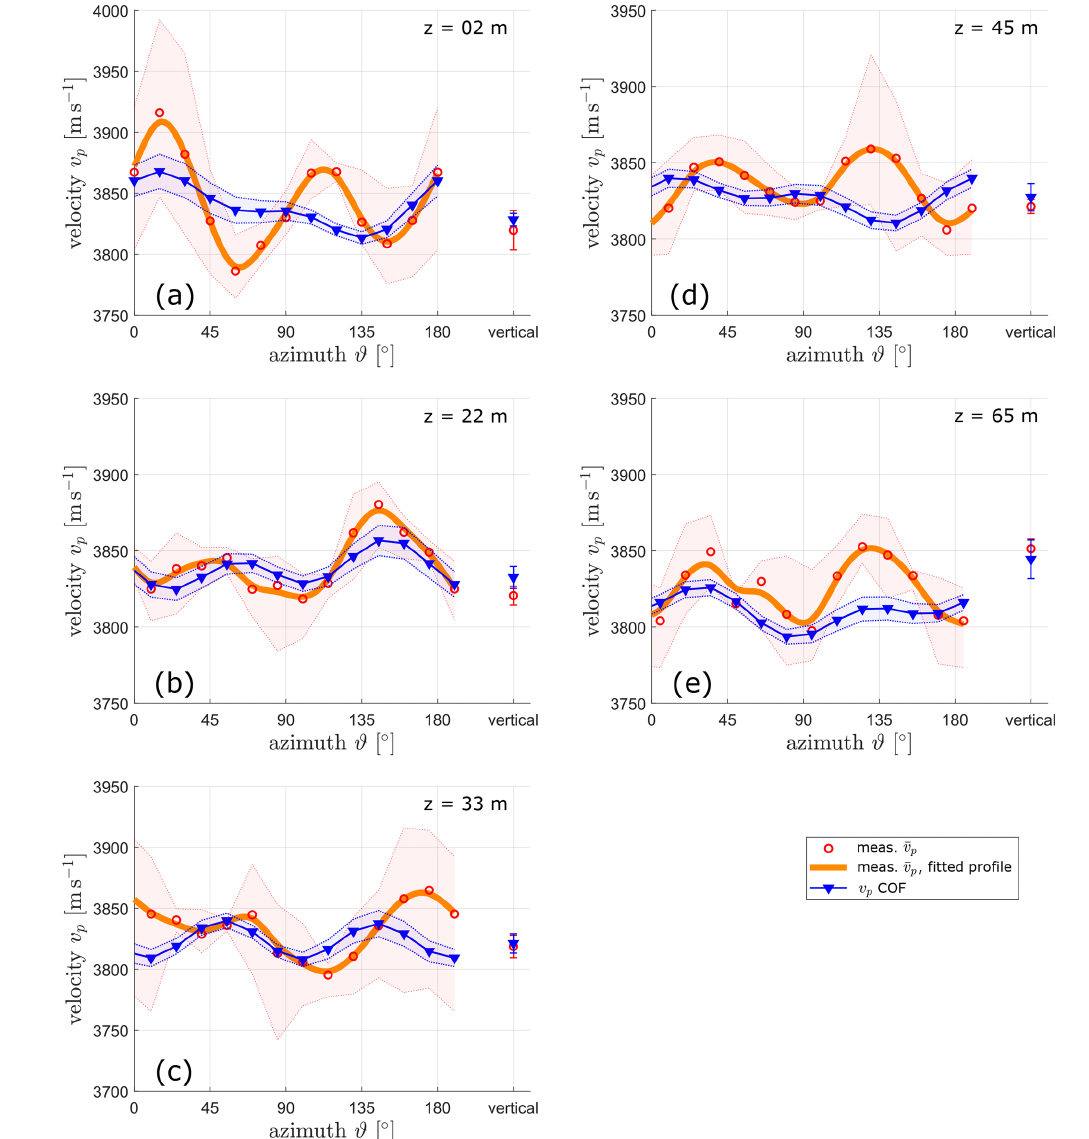
Figure 4. Mean measured seismic velocities from ultrasonic experiments (orange curve and red dots) with maximum and minimum values (light red areas) for five ultrasonic samples and the corresponding calculated velocities from the COF distribution (blue curve) from Fig. 2 with Voigt and Reuss bounds. These graphs show the horizontal measurements, ϕ = 90 ◦ . The respective vertical measurement ( ϕ = 0 ◦ ) is added to each diagram. Depth indicated in upper-right